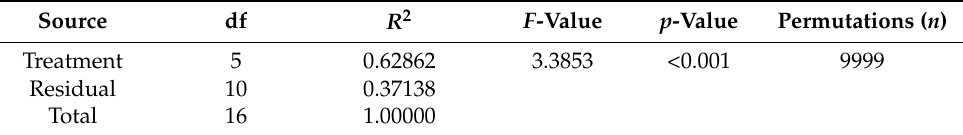
Table 6. Summary of PERMANOVA of the effect of amendment application (N3, N5, PMS50,